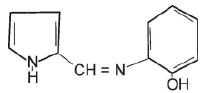
Figure 1. Structure of the